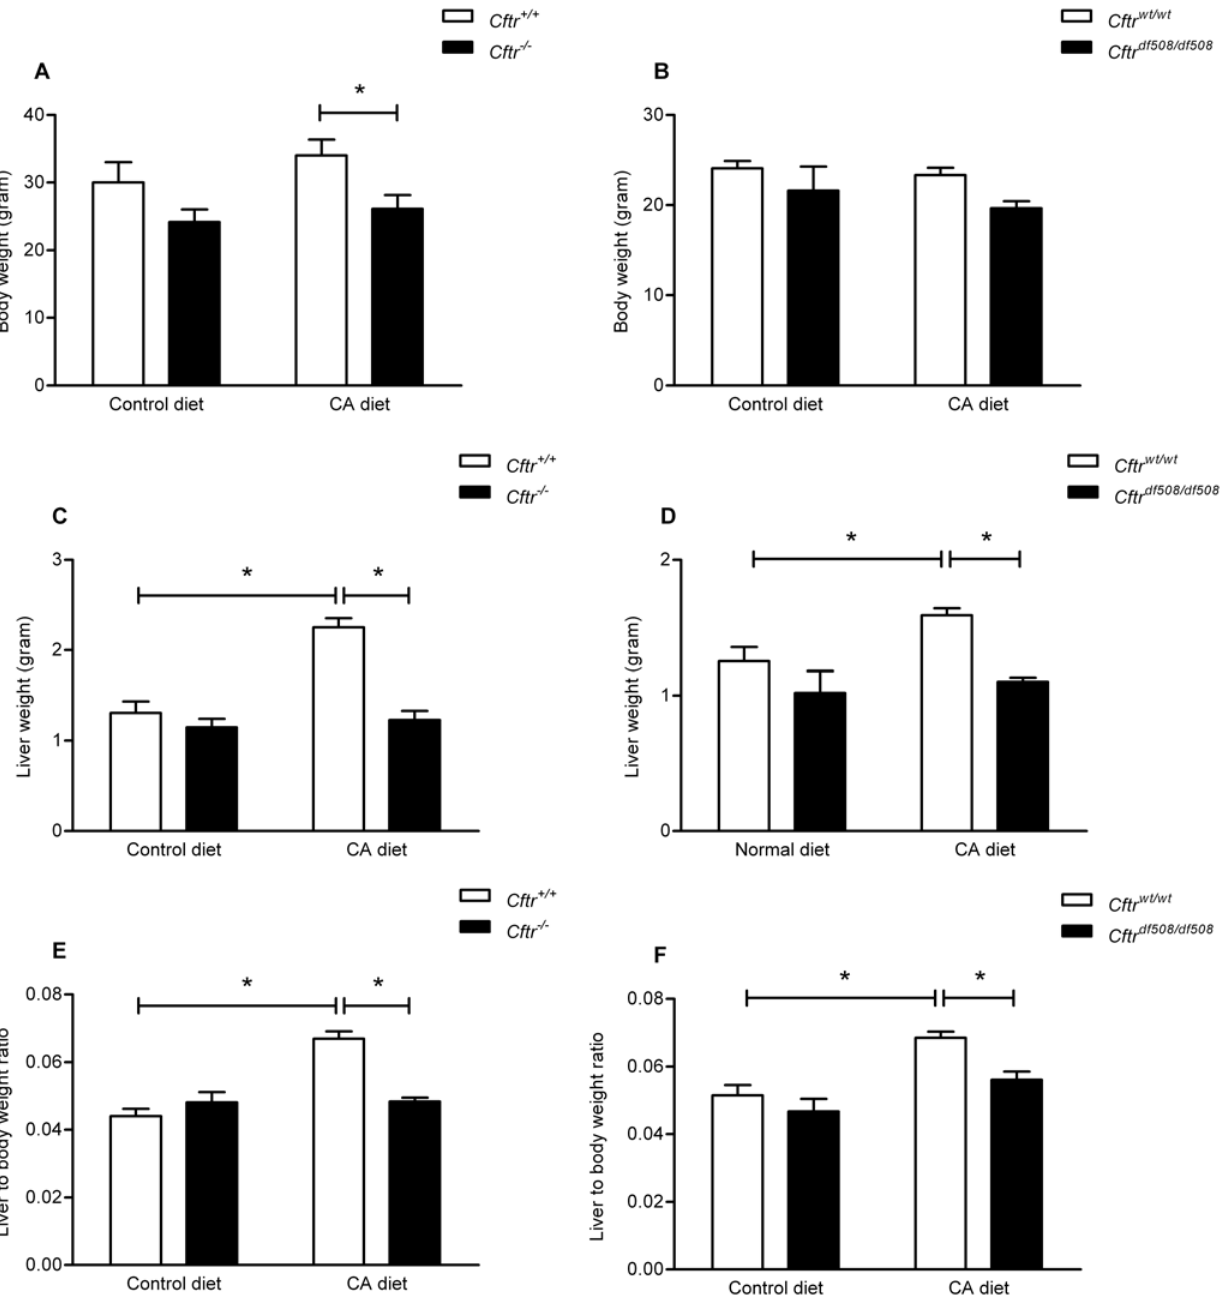
Fig 3. Hepatic Cyp7a1 mRNA expression Cftr knockout mice (Cftr -/- ) and controls, fed a control diet or a cholic acid (CA) containing diet for 3 weeks. Hepatic Cyp7a1 mRNA expression after a control (A) or 0.5%-CA (wt/wt) chow diet (B) for three weeks. Cyp7a1 mRNA levels were normalized to a housekeeping gene ( β -actin) in Cftr knockout mice ( Cftr -/- ) and control littermates ( Cftr +/+ ). Data are presented as means ± SEM of N = 5 – 7 mice per group. * P-value <